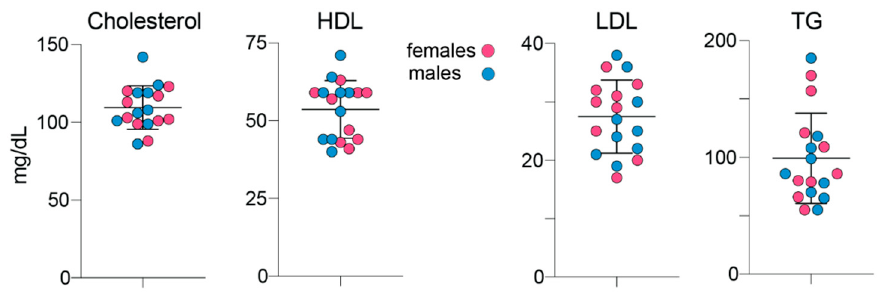
Figure 7. Fasting serum lipids in 6-month old hamsters. Data represent the mean ± SD of measurements in each hamster: 9 females and 9 males. No sex-based differences were detected, hence data from female and male animals were combined. HDL, high density lipoprotein cholesterol; LDL, low density lipoprotein cholesterol; TG, triglycerides.